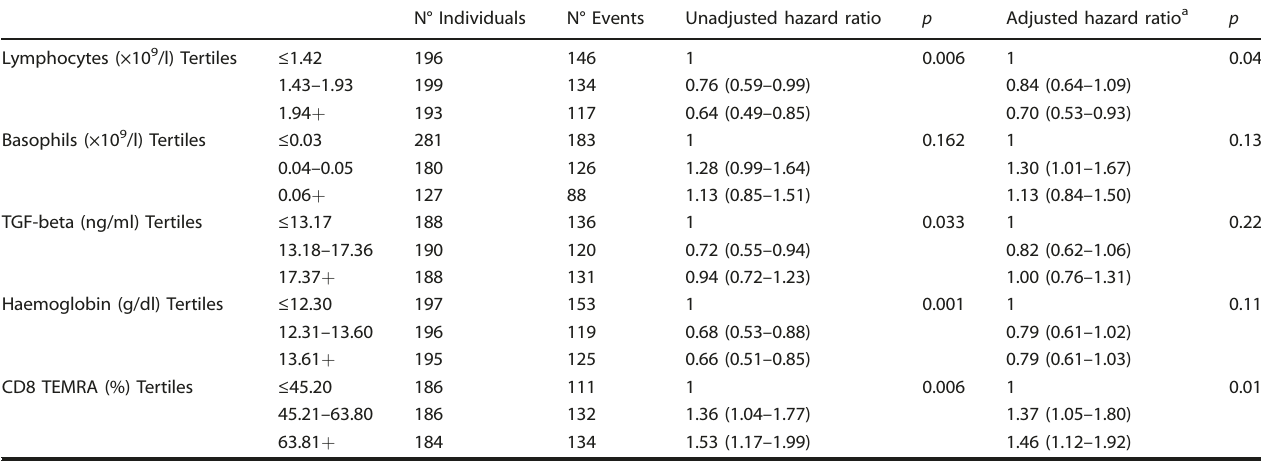
Table 1. All cause mortality Cox-regression model: CD8 TEMRA.